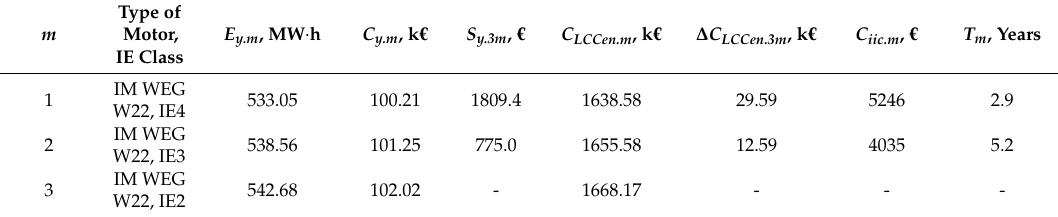
Table 4. Energy consumption and cost savings calculation results.